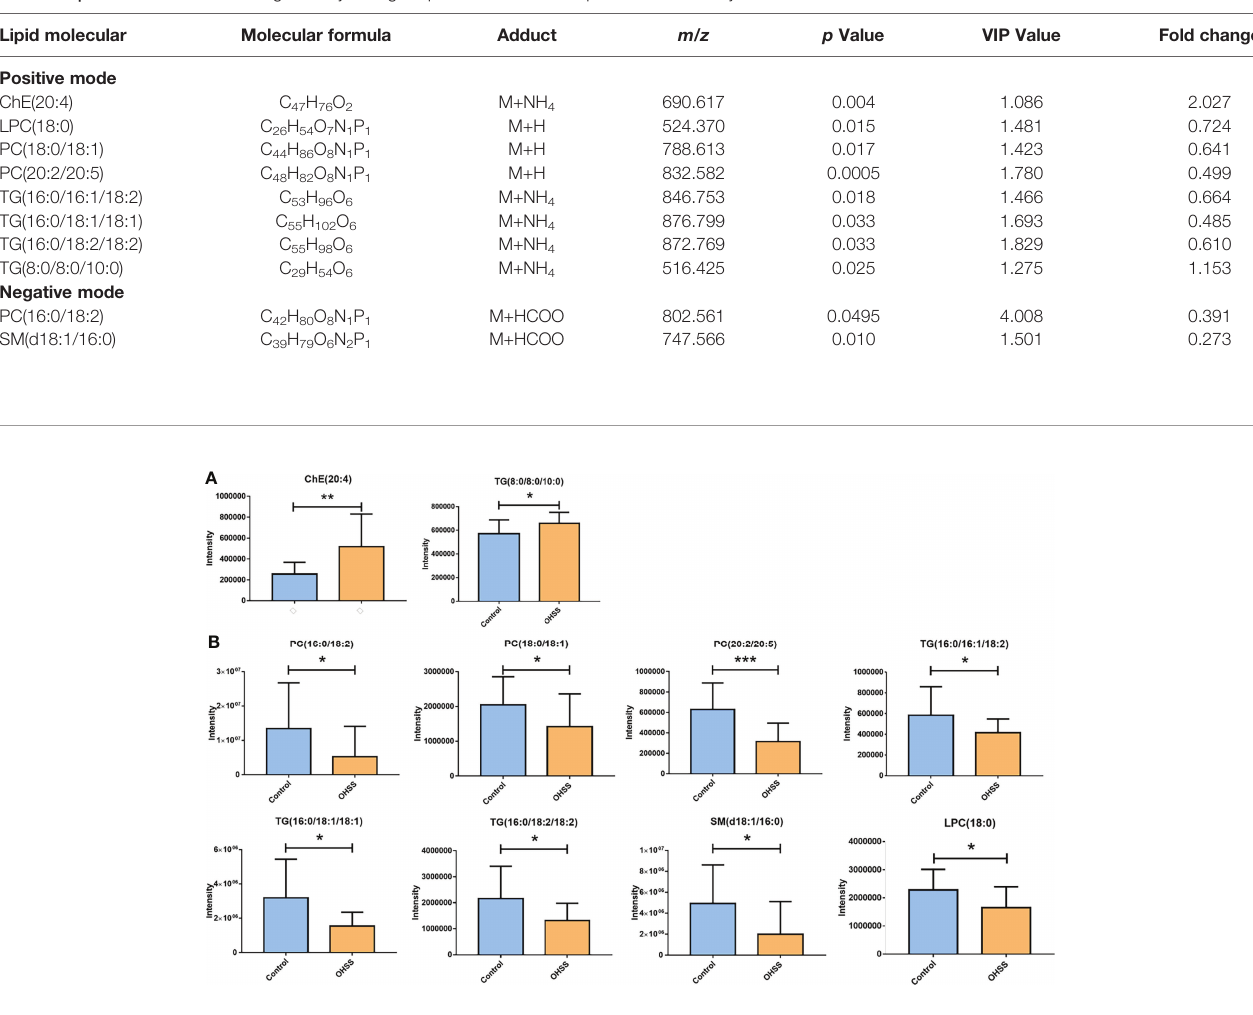
FIGURE 3 | The intensities of ChE(20:4) and TG(8:0/8:0/10:0) were higher in OHSS group (A) . The intensities of LPC(18:0), SM(d18:1/16:0), PC(18:0/18:1), PC (20:2/20:5), PC(16:0/18:1), TG(16:0/18:1/18:1), TG(16:0/18:2/18:2) and TG(16:0/16:1/18:1) were lower in OHSS group (B) . Data are expressed as mean ± S.D. * p < 0.05, ** p < 0.01, *** p < 0.001, OHSS patients (OHSS, n = 17) vs. healthy controls (Control, n =